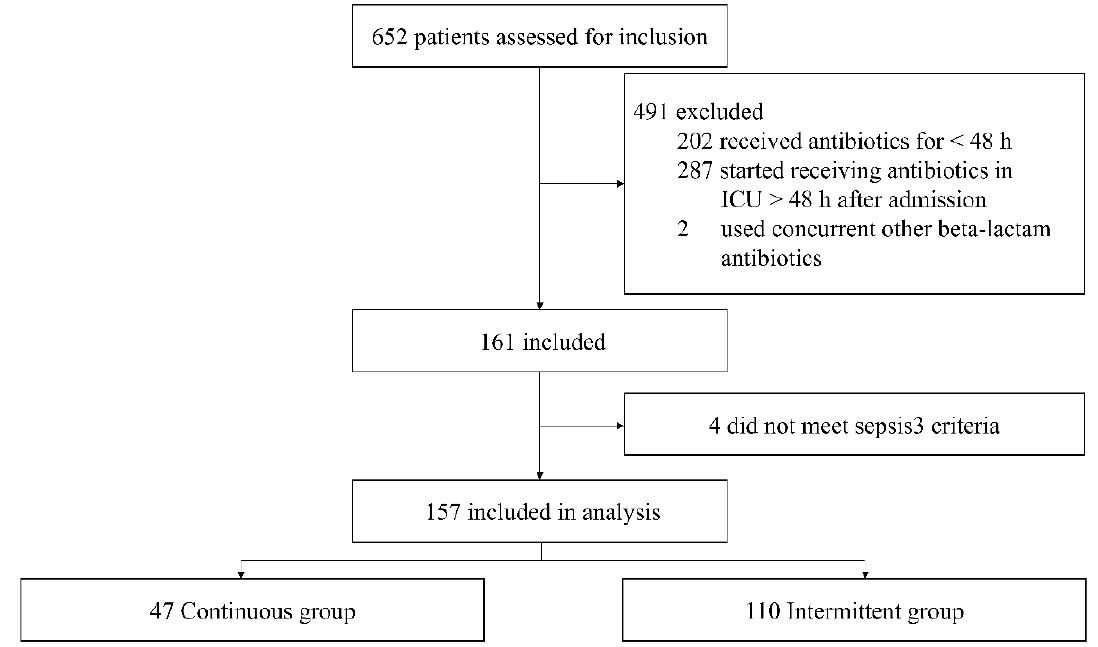
Figure 1. Flowchart of all excluded and included patients. ICU, intensive care unit.